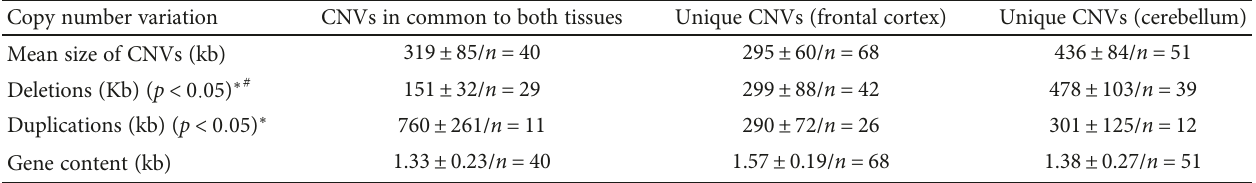
CNVs: DNA copy number variations. ( ∗ p < 0 05 ) One-way ANOVA, signi fi cant di ff erence among means. ( # p < 0 05 ) Bonferroni ’ s posttest, in common CNVs versus unique CNVs from the